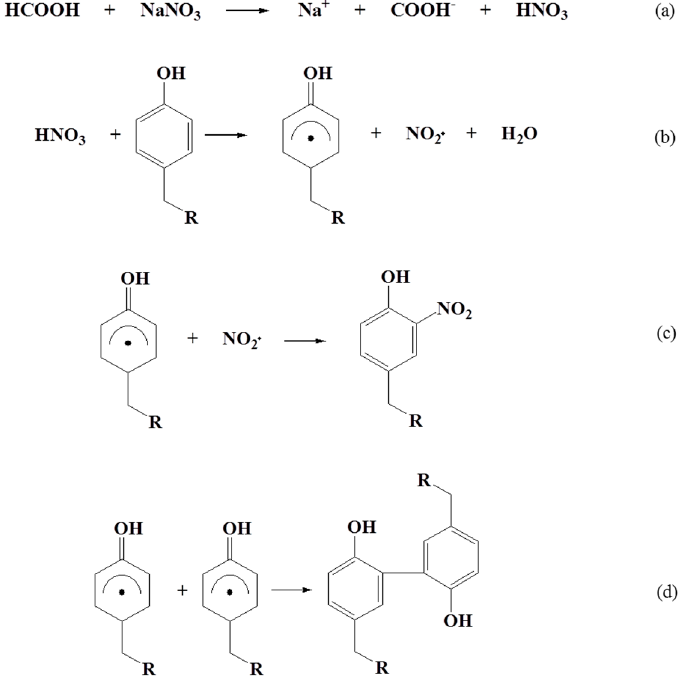
Figure 9. Gelation mechanism of SF/formic acid solution with NaNO 3 . ( a ) addition of NaNO 3 ; ( b ) tyrosyl radical formation; ( c ) nitration of tyrosine; ( d ) cross-linking of tyrosine.